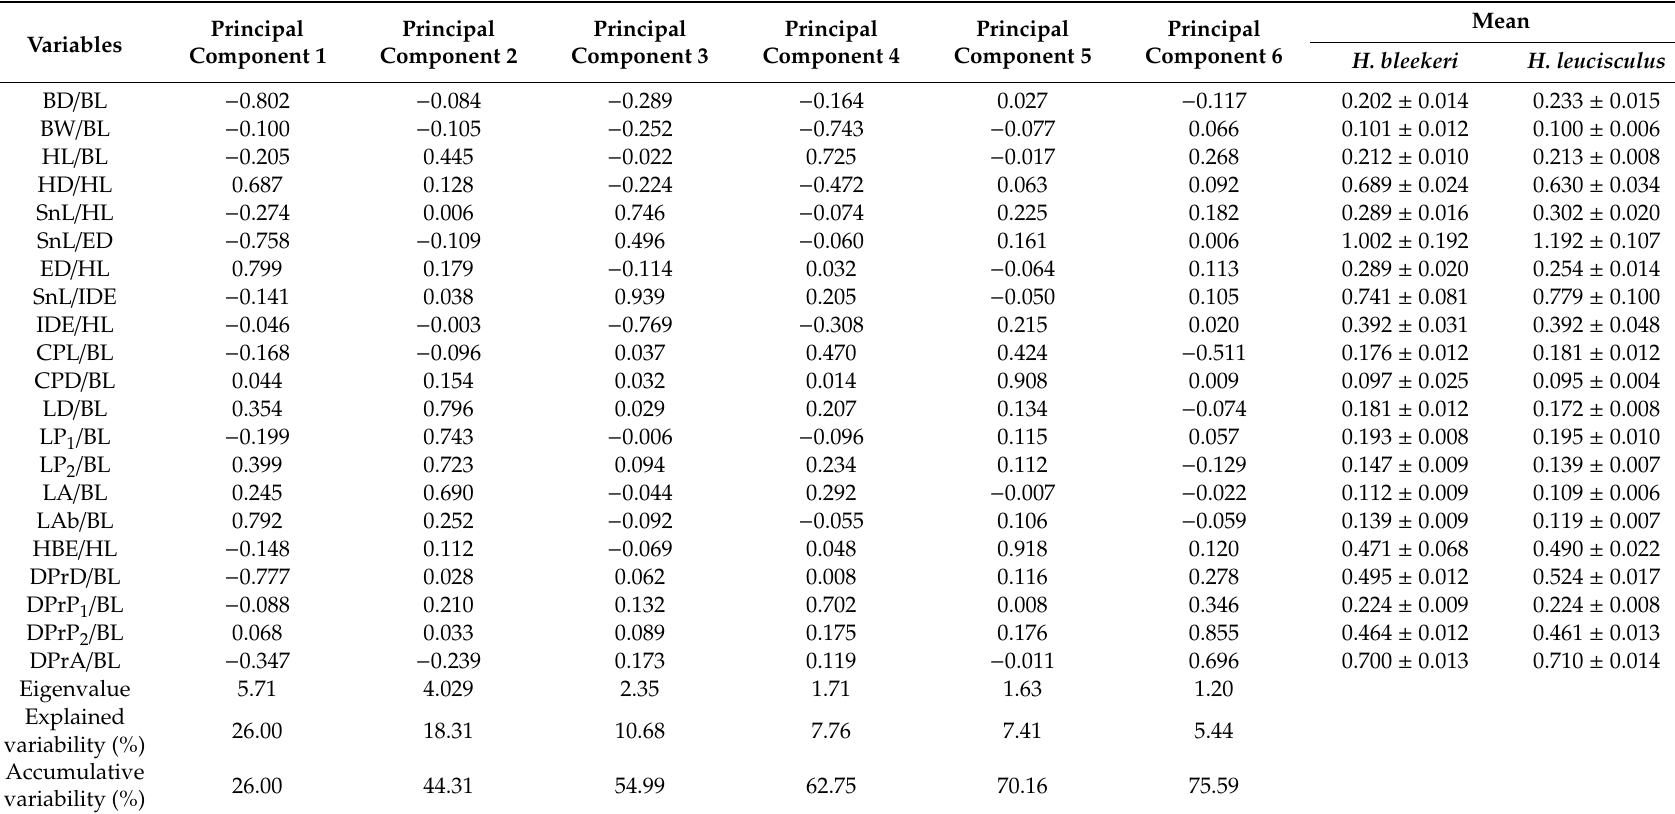
Table 1. Percentage of explained variance and weights of 21 morphometric characteristics (corrected based on standard body / head length) in six principal components (PCs), and the mean and standard deviation of morphometric characteristics in PC1. See Figure 4 for abbreviations. Sample number ( n ) =